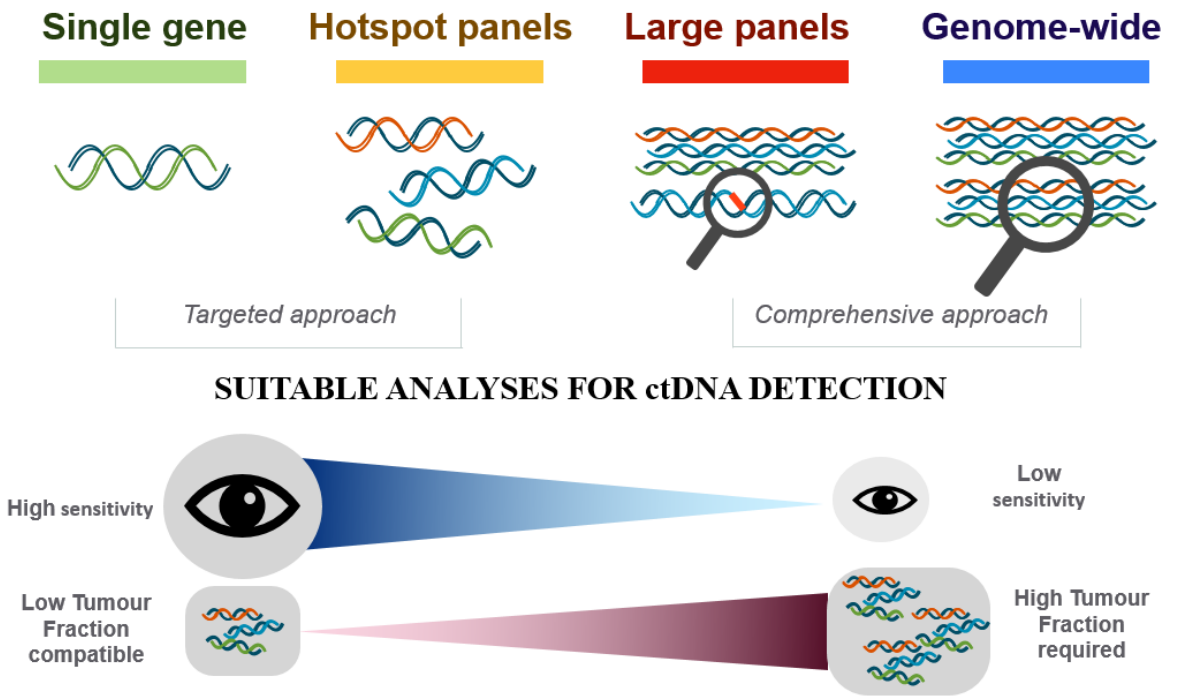
Figure 1. Targeted vs. genome-wide approach in ctDNA analysis.